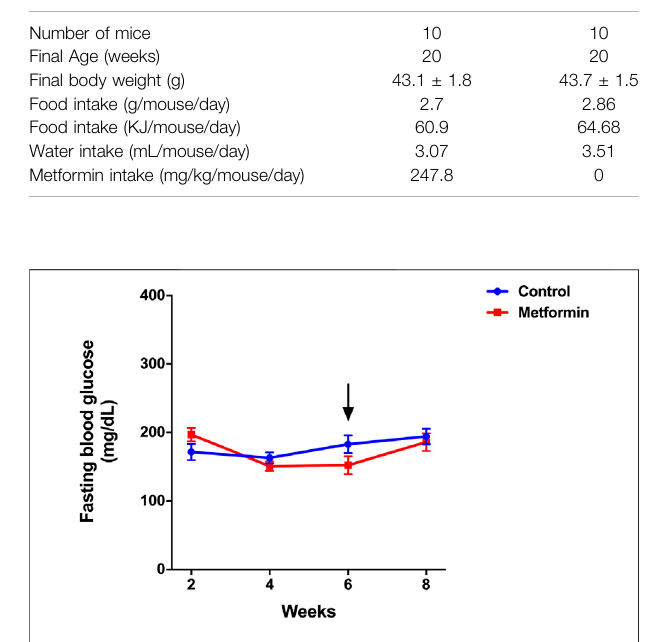
FIGURE2| Fastingblood glucose ofmetforminand controlgroupsover the period of 8 weeks. Data was presented as mean ± standard error of the mean. The arrow denotes the start of metformin or placebo treatment.